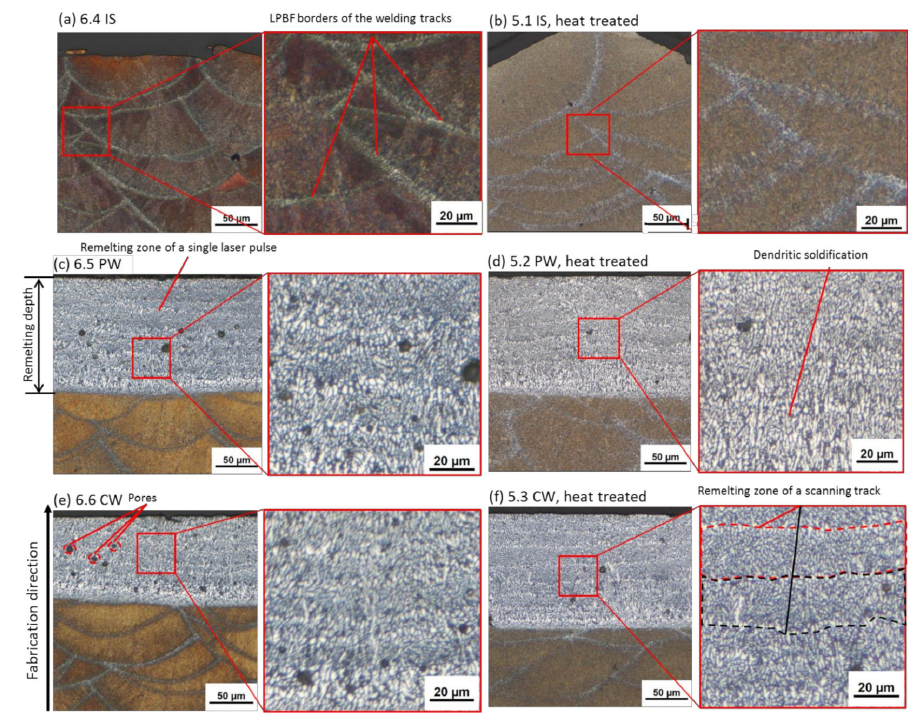
Figure 11. Microstructure at the cross section in y-direction, etched with Murakami, ( a ) initial state, ( b ) initial state, heat treated, ( c ) polished with pulsed laser radiation, ( d ) heat treated and polished with pulsed laser radiation, ( e ) polished with continuous laser radiation, ( f ) heat treated and polished with continuous laser radiation.